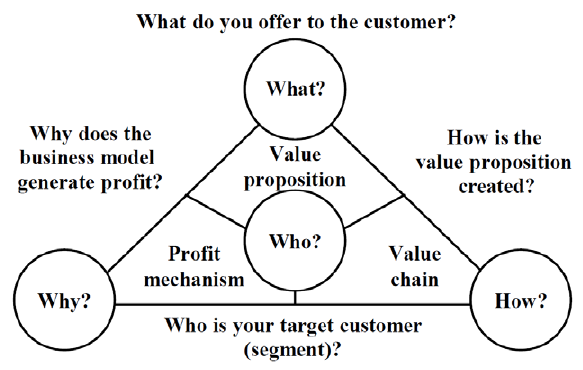
Figure 2. Business model innovation – the magic